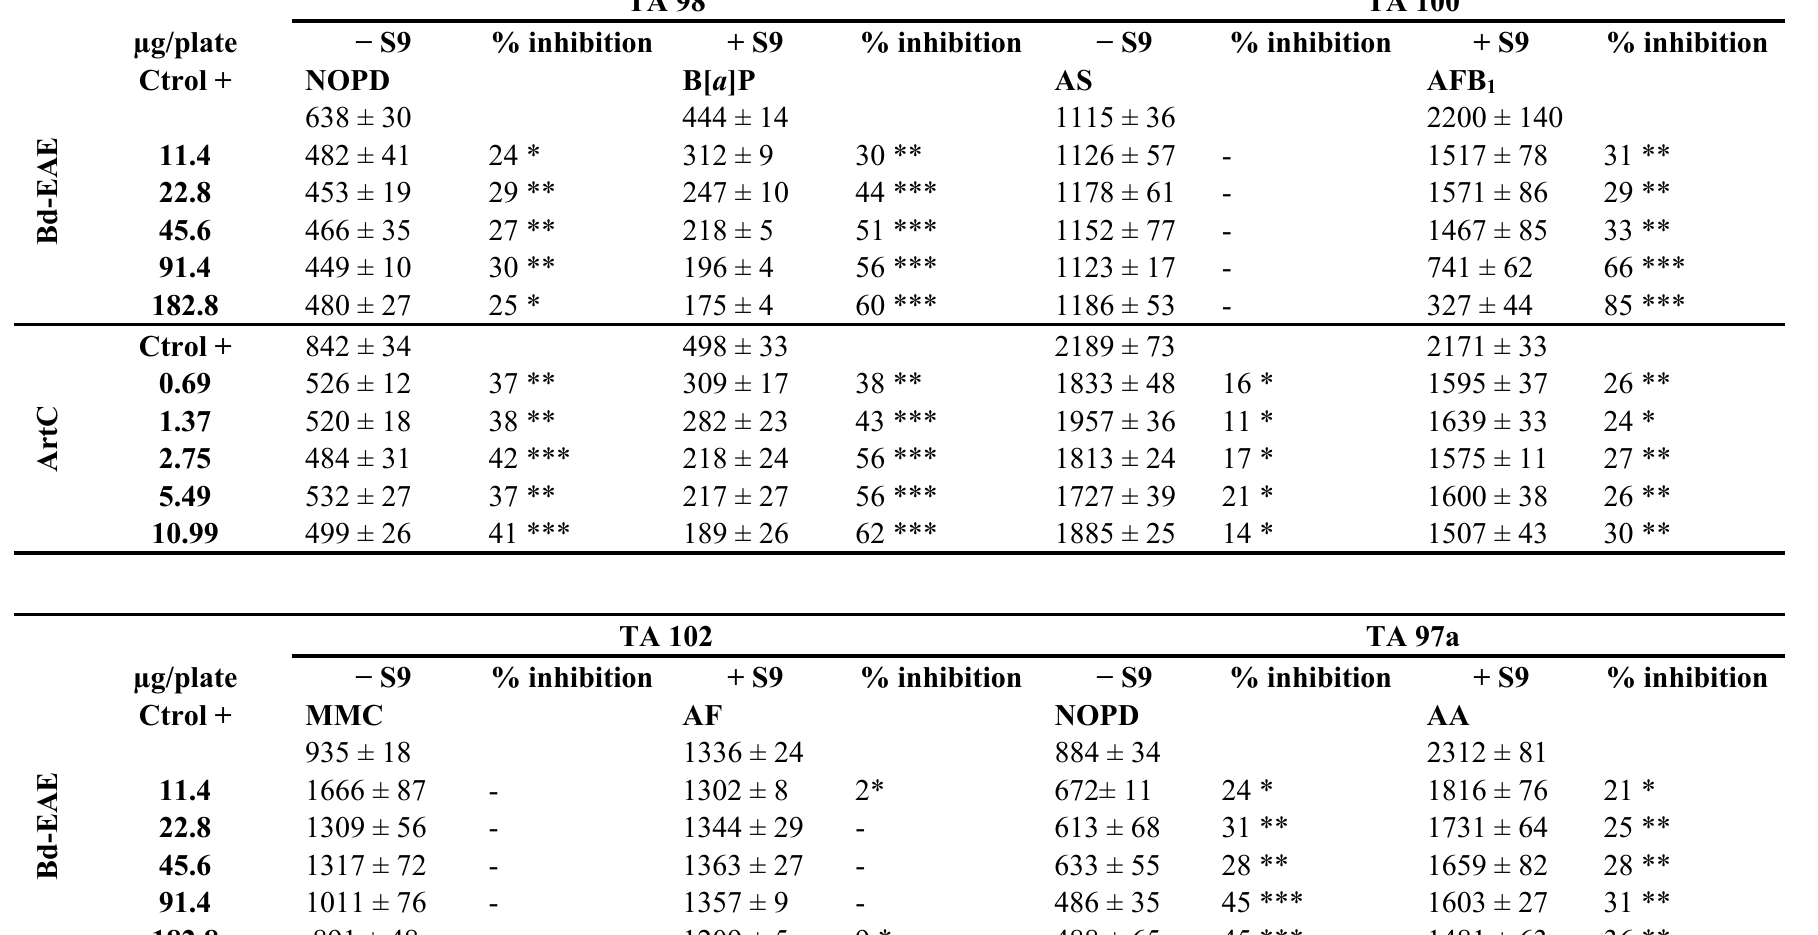
Table 2. Antimutagenic activity expressed as the mean and standard deviation of number of revertants and percent inhibition by Bd-EAE and ArtC of direct (-S9) and indirect (+S9) mutagens, tested on strains TA98, TA100, TA102 and TA 97a of S. typhimurium.